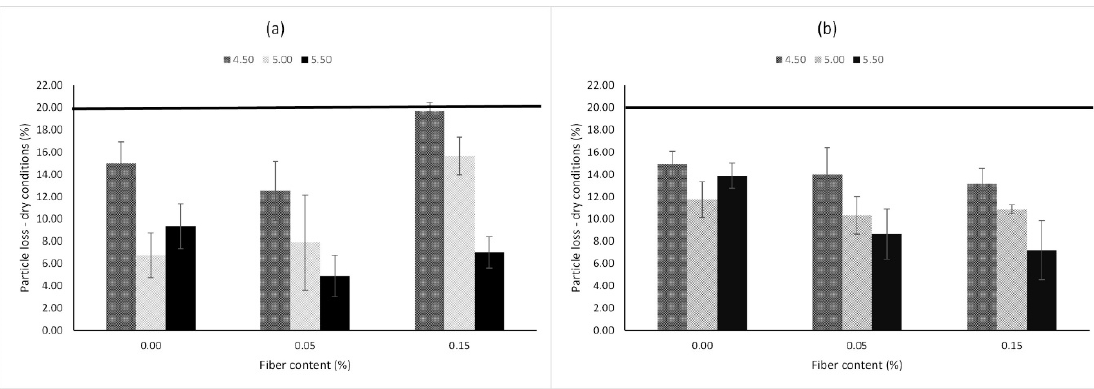
Figure 8. Particle loss in dry conditions of PA mixtures. ( a ) Limestone; ( b ) mixed filler.